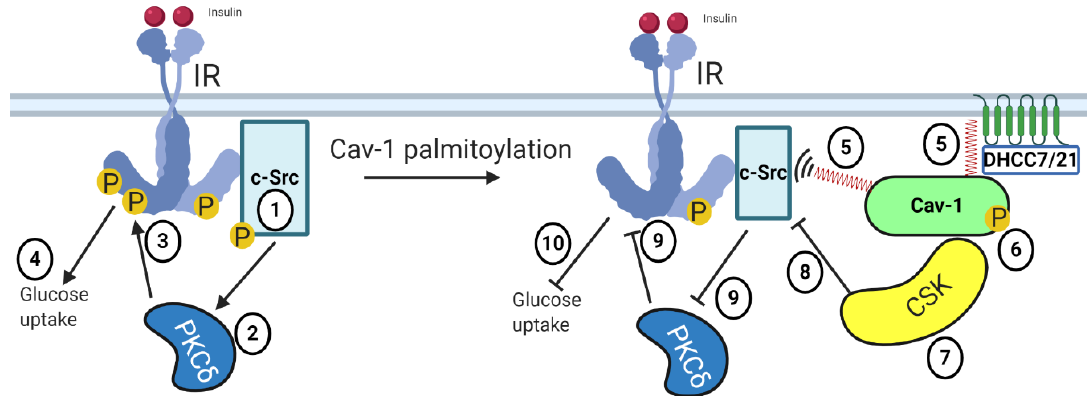
Figure 4. Hypothetical role of Cav-1 palmitoylation within the insulin signaling cascade. In the absence of Cav-1 palmitoylation, insulin stimulates c-Src kinase phosphorylation (1), triggering PKCδ kinase activation (2). Both c-Src and PKCδ kinases contribute to the stimulation of IR phosphorylation (3), ultimately inducing glucose uptake (4). Palmitoylation of Cav-1 (by DHHC7/21) allows interaction with c-Src (5), which then phosphorylates Cav-1 (6). Cav-1 phosphorylation is the signal for the recruitment of C-terminal Src kinase (Csk) (7), which inhibits c-Src kinase (8). Consequently, activation of PKCδ and IR phosphorylation are hindered (9), which mitigates insulin-stimulated glucose uptake (10). (Palmitate moieties represented as spring-red shape).